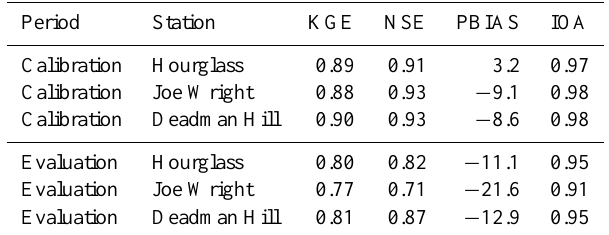
Table 4. Goodness of fit values for the calibration (top) and evalua- tion periods (bottom) for the site-specific calibrations at three SNO- TEL stations and for the model C1 at a daily time step.